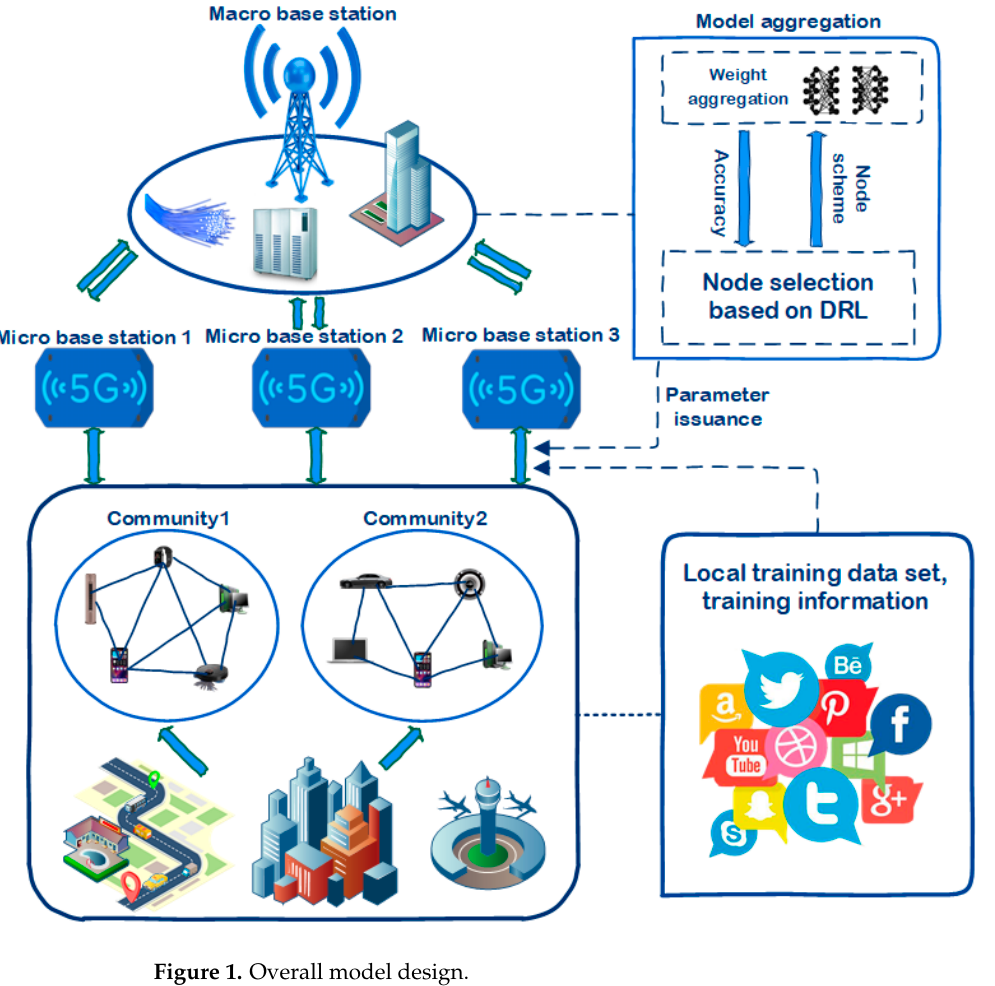
Figure 1. Overall model design.